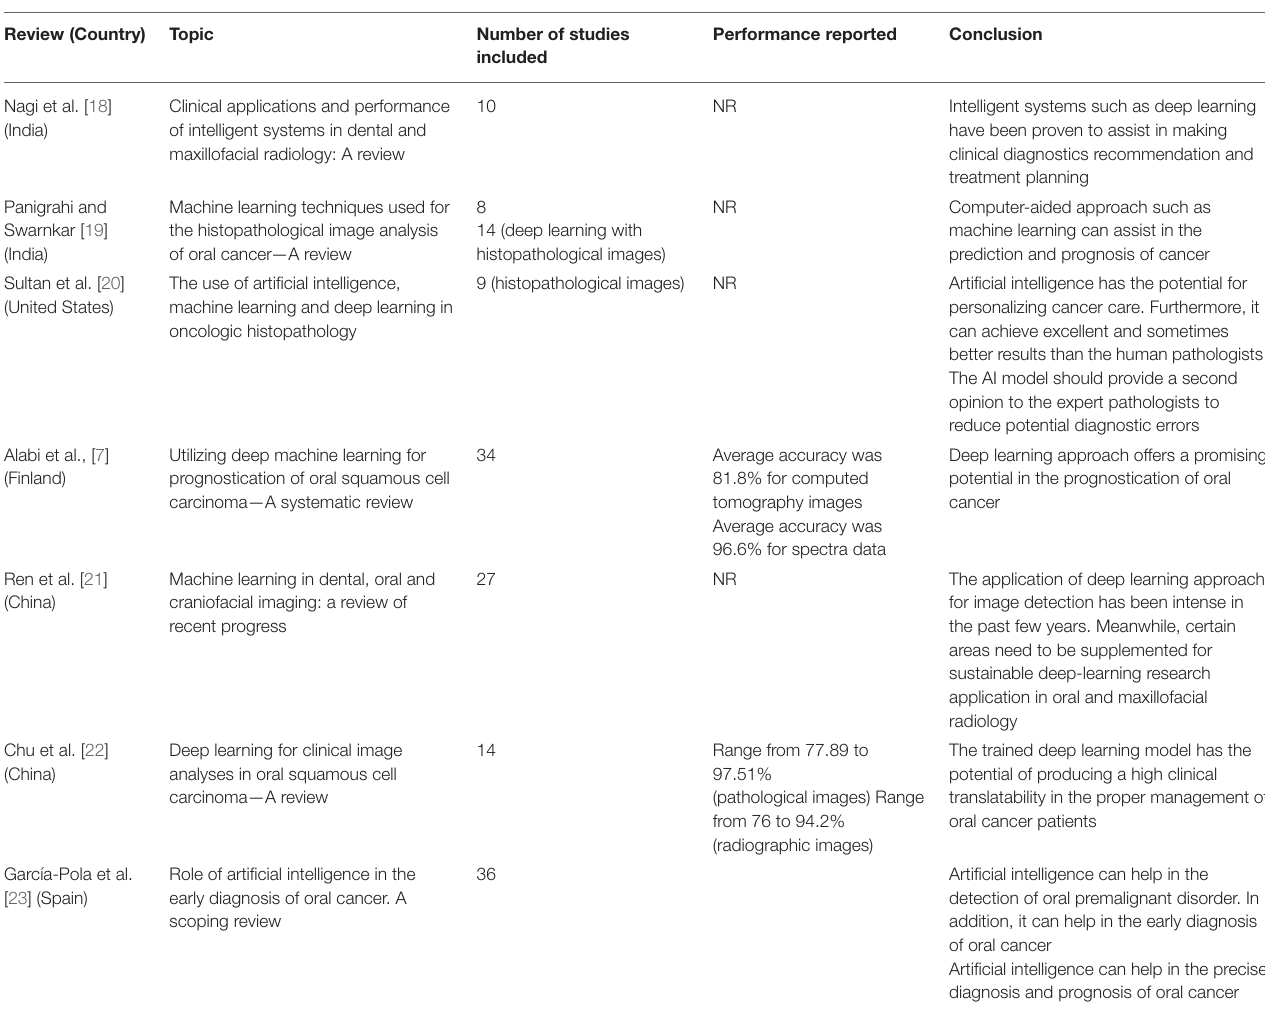
TABLE 2 | Summary of review studies on the application of deep learning in oral cancer. Review (Country)